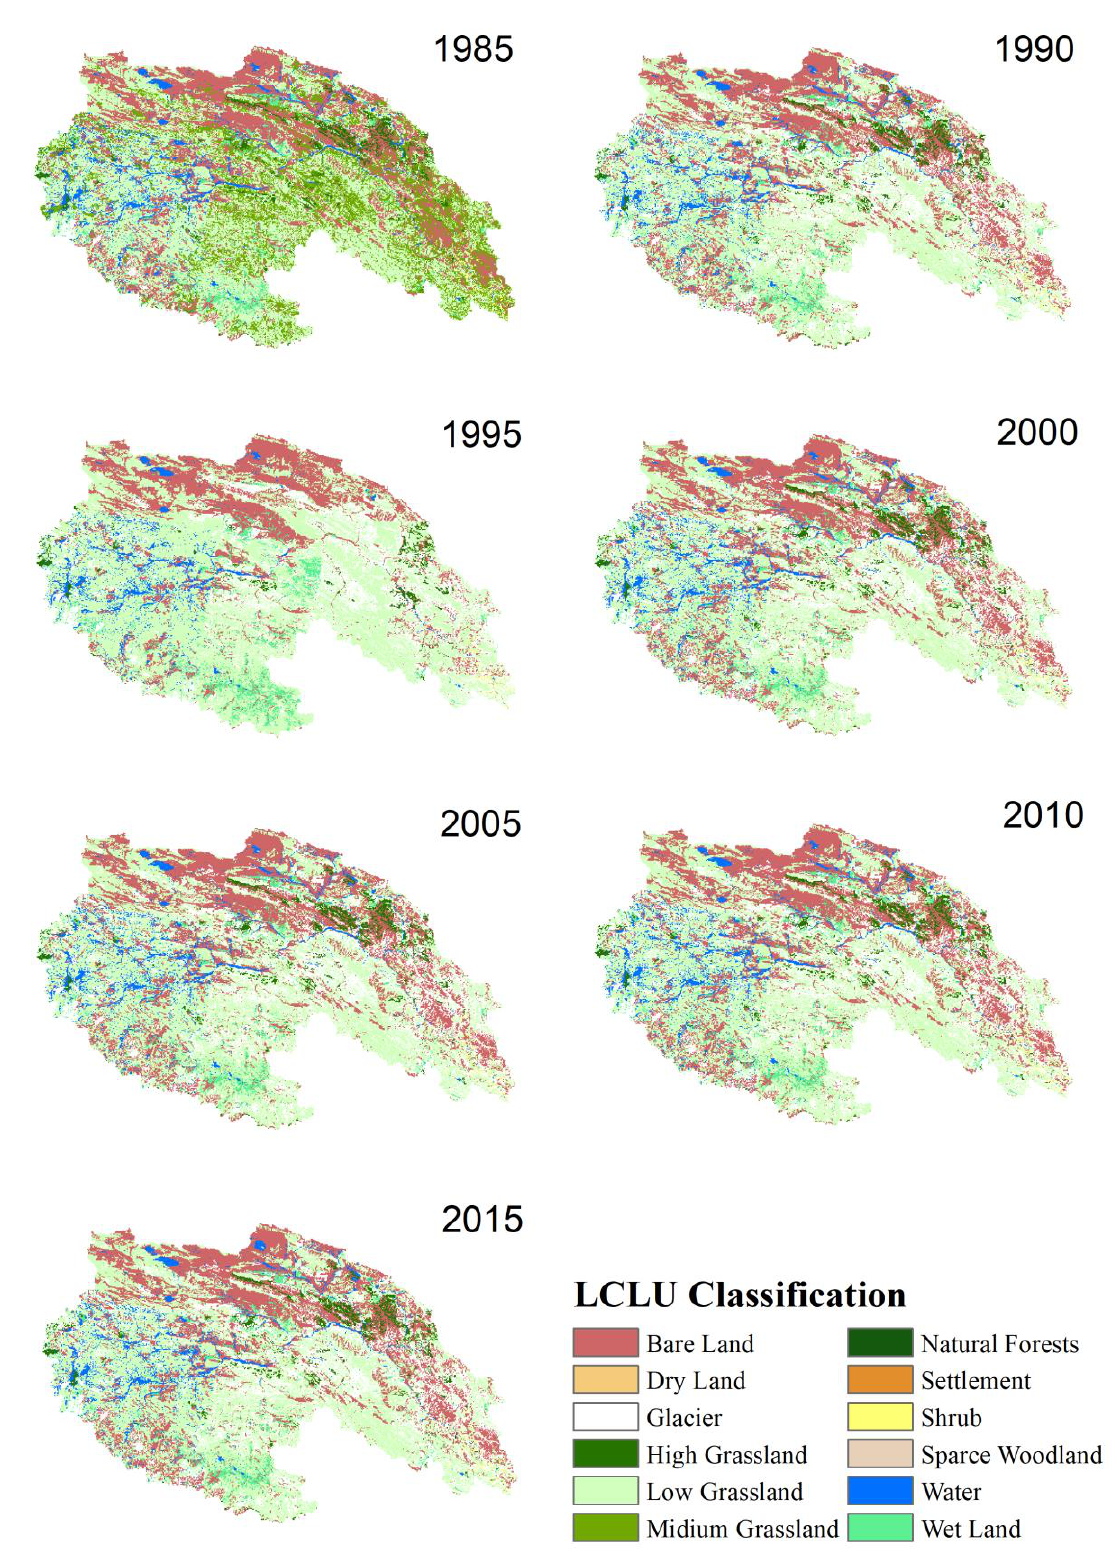
Figure 12. Spatial distribution of land-cover types during 1985 to 2015 in the YRSR.